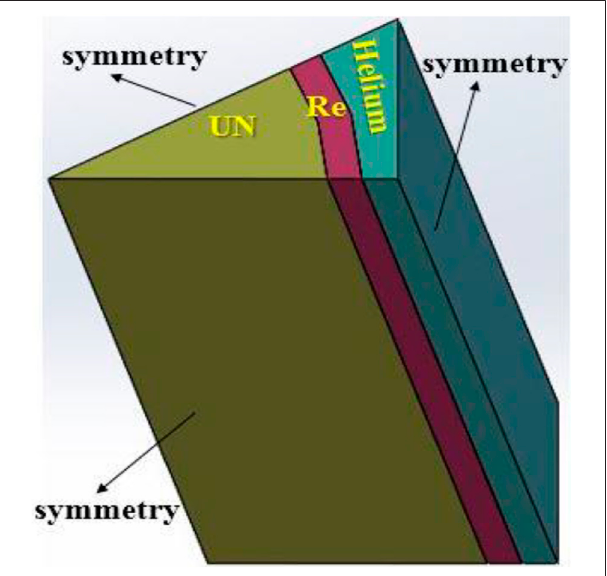
FIGURE 5 | Schematic of 1/12 of the individual